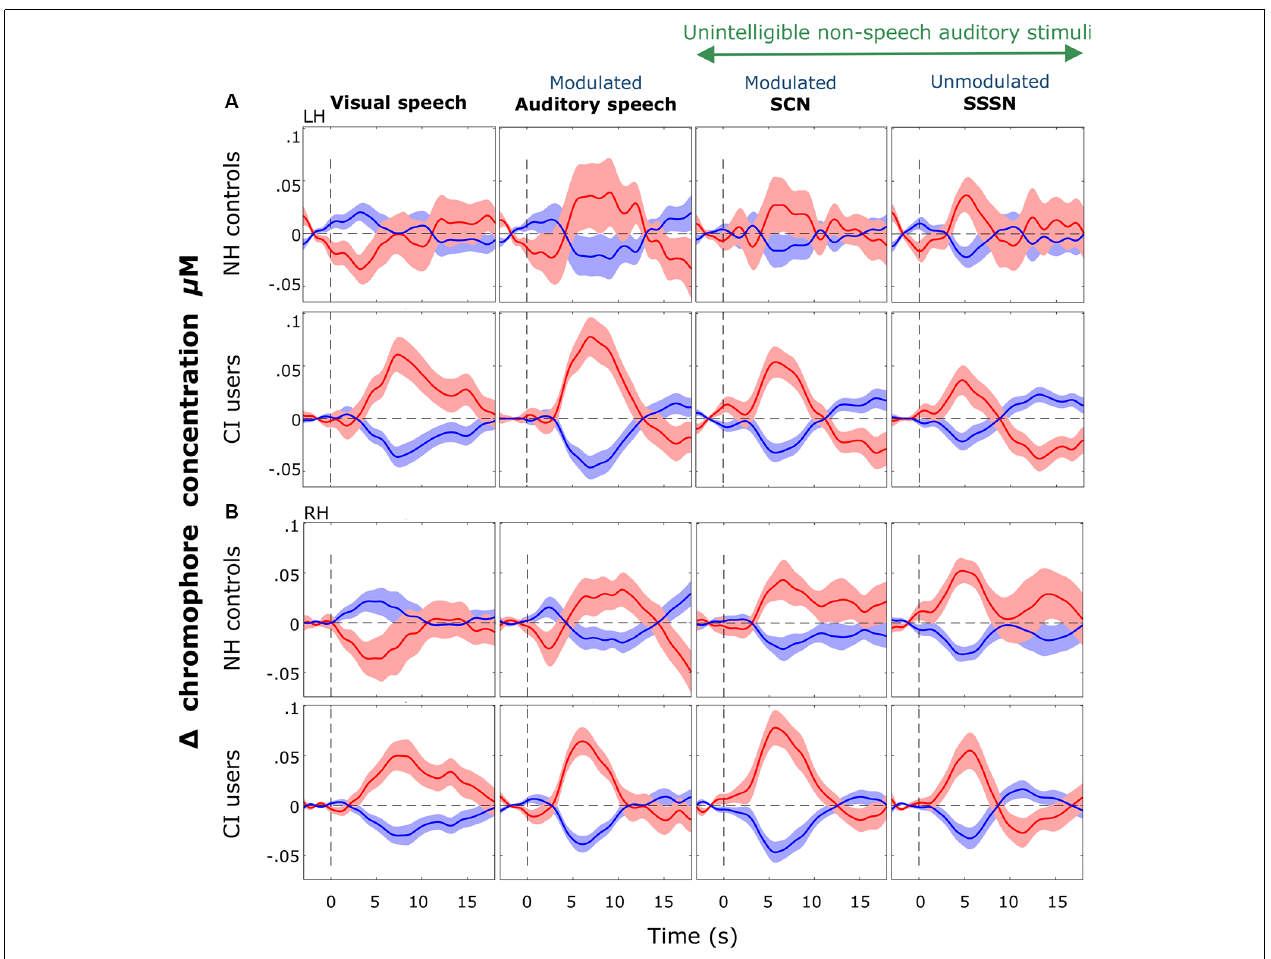
FIGURE 8 | Block-averaged hemodynamic time courses derived from the ROI. These are displayed for each stimulation condition (response to silent trials subtracted out) for each group in the LH (A) and the RH (B) . Shaded regions indicate ± 1 standard error of the mean across participants. Responses were averaged across channels 9, 10, and 12 in the LH and channels 20, 21, and 23 in the RH. Notably greater variation was observed in cortical responses recorded from the NH group than the CI group in both hemispheres but more so in the LH. Strong positive responses to visual speech were observed bilaterally in the CI group with a prominent deactivation shown in response to visual speech in NH